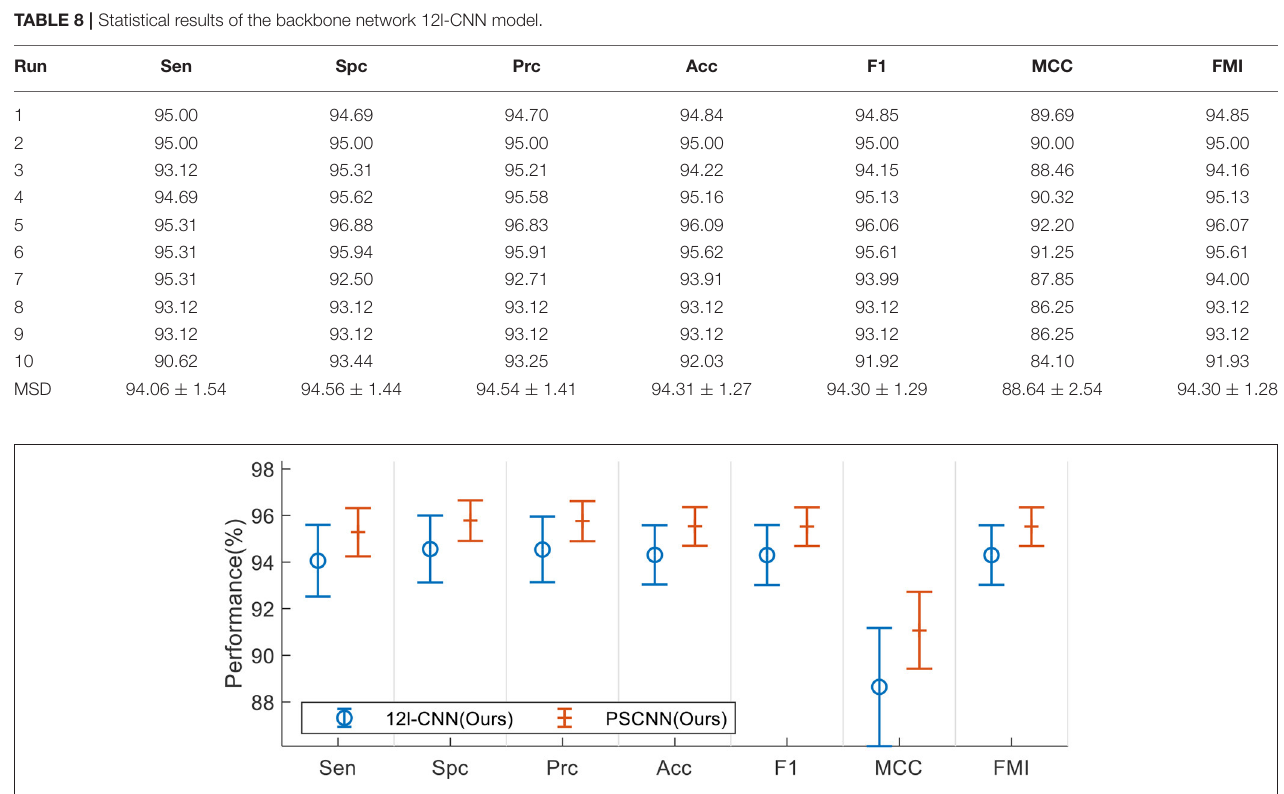
FIGURE 14 | Error bar of comparing 12l-CNN against